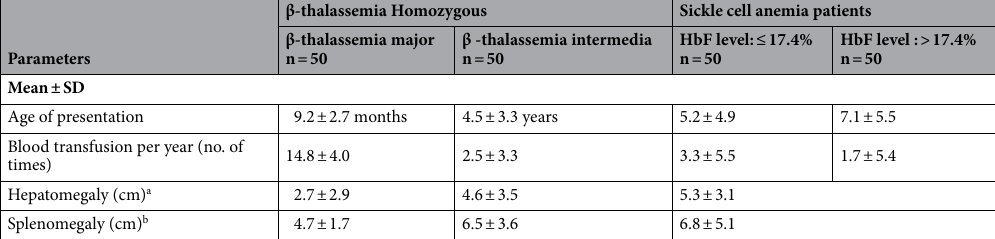
Table 1. Clinical characteristics among the patient groups. n Number of patients. a Hepatomegaly pronounced in thalassemia intermedia and Sickle cell anemia patients. b Splenomegaly in thalassemia intermedia and Sickle cell anemia patients.